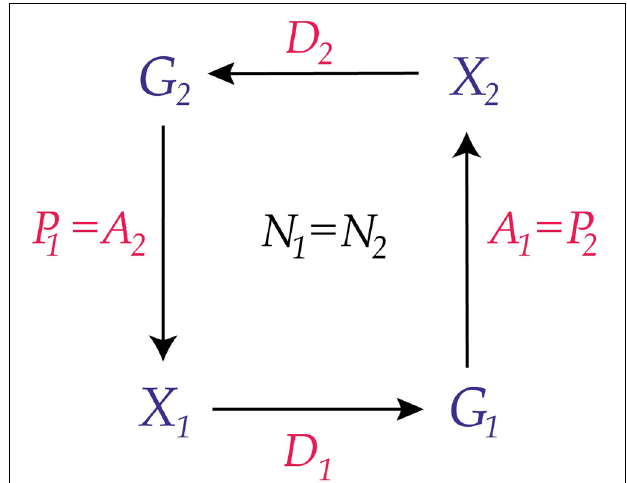
FIGURE 2 | Two conscious agents, C 1 and C 2 . Each is part of the world W for the other conscious agent. The lower part of the diagram represents C 1 and the upper part represents C 2 . This creates an undirected combination of C 1 and C 2 , a concept we define in section The Combination